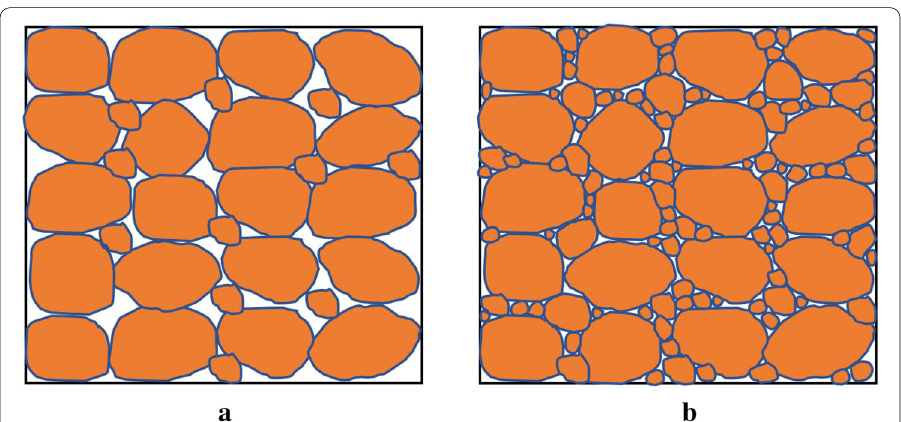
Fig. 15 Packing structures of a poorly graded soil (low C u ) and b well‑graded soil (high C u